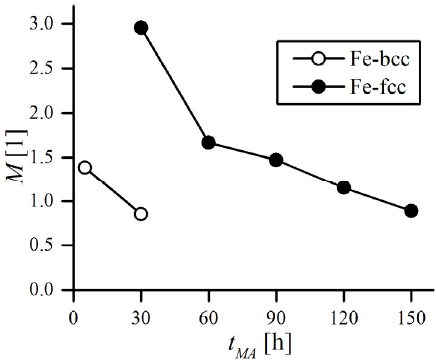
Figure 12. Trend of the Wilkens parameter M in the function of milling